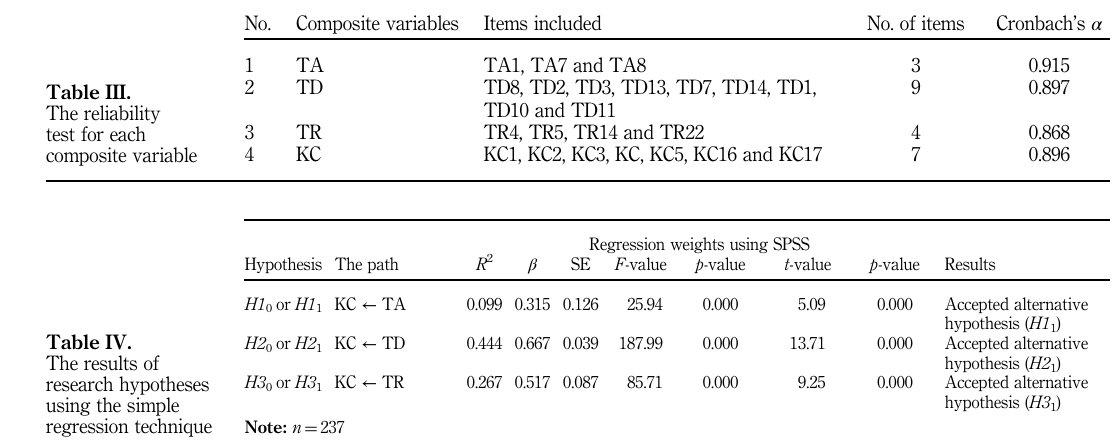
research hypotheses using the simple regression